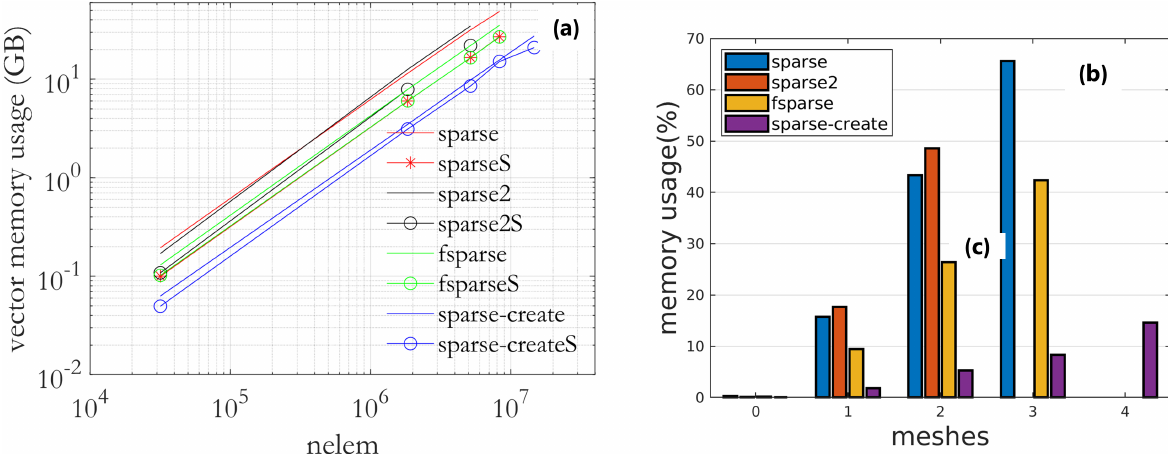
Figure 12. (a) Vector memory vs nelem (b) Percentage of memory consumed by KG versus available memory.